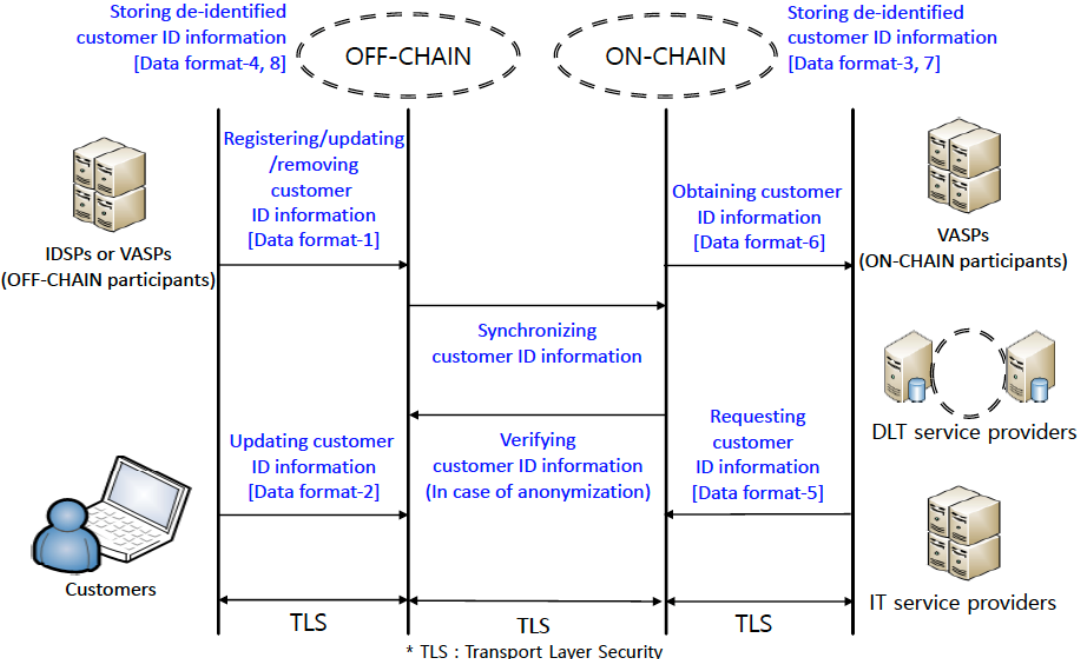
Figure 6. Service scenario and data flow.